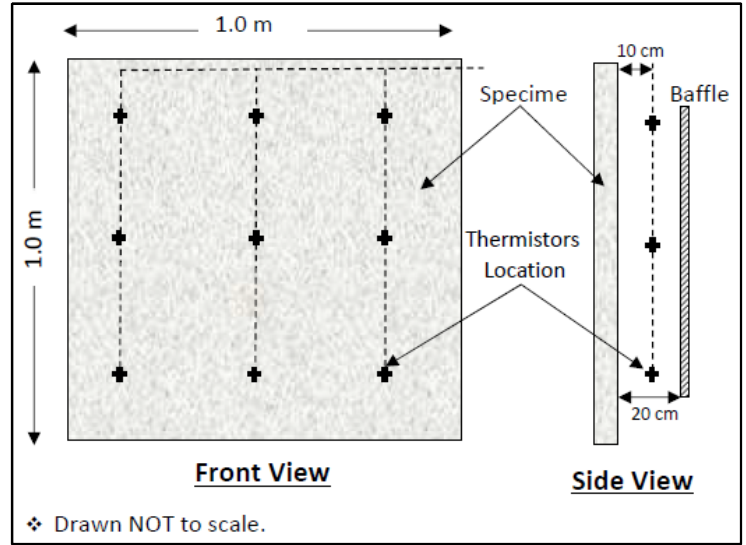
Figure 5. Scheme of temperature sensors’ layout.